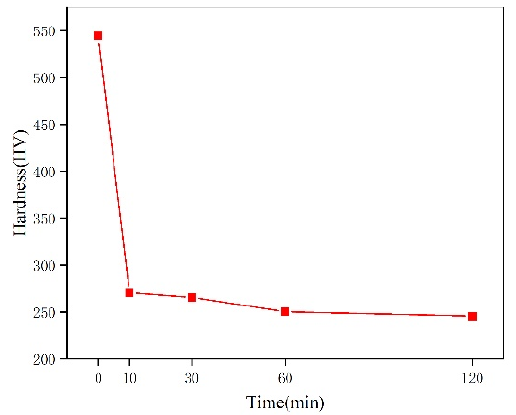
Figure 7. Relationship between annealing time and hardness at 1150 °C.